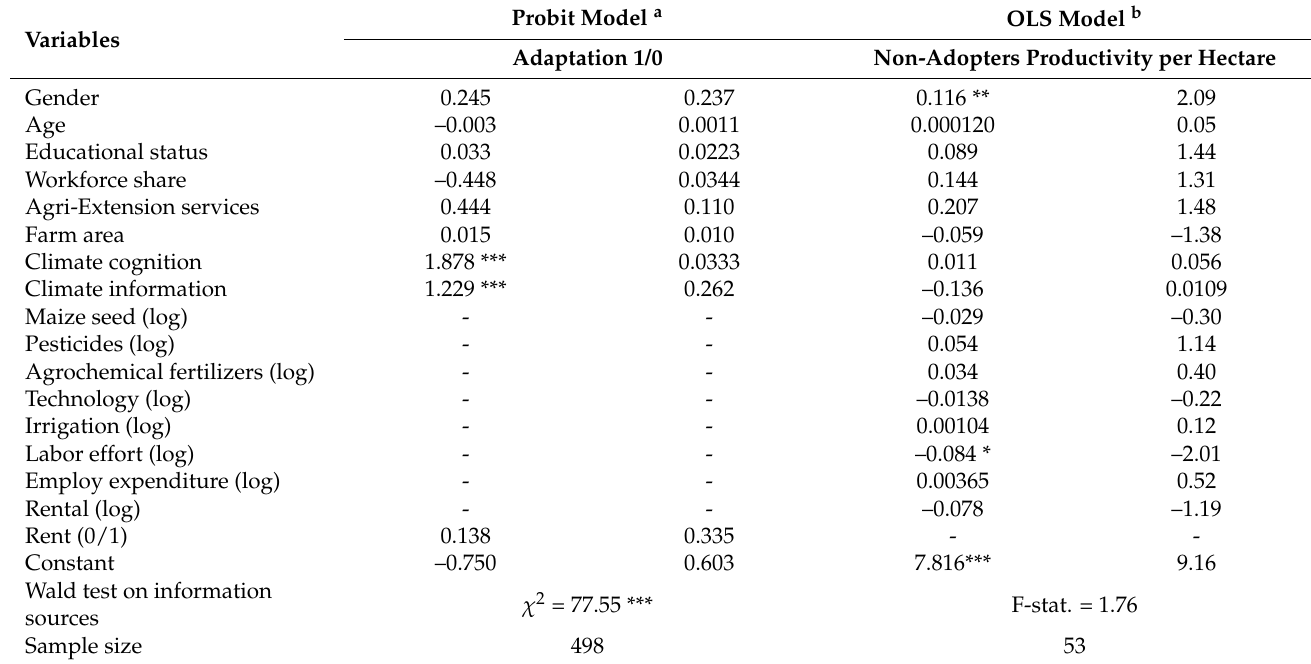
Table A1. Parameter estimates—Validity testing of selection